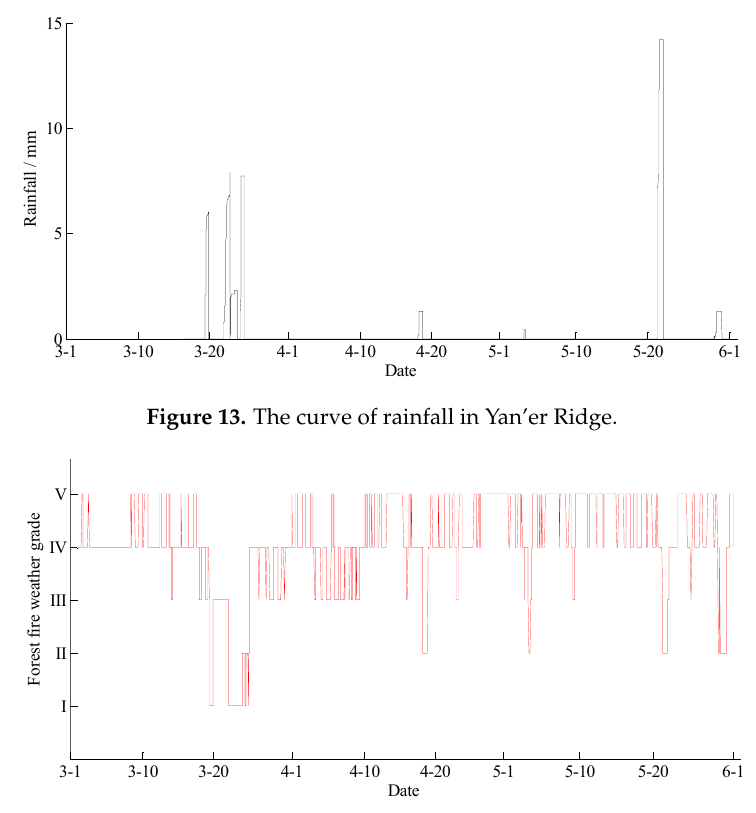
Figure 12. The curves of soil water content in 10 and 40 cm depth in Yan’er Ridge.